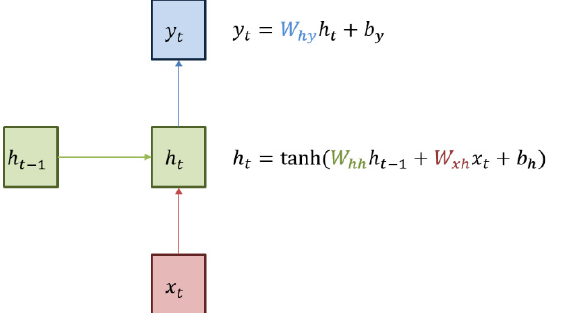
Figure 12. Basic architecture of the recurrent neural network. The green boxes indicate hidden states (h), the red box is the input (x), and the blue box is the output (y). The current hidden state (h t ) is updated by using the previous hidden state (h t−1 ). The current output (y t ) is updated using h t , as shown by the formula.